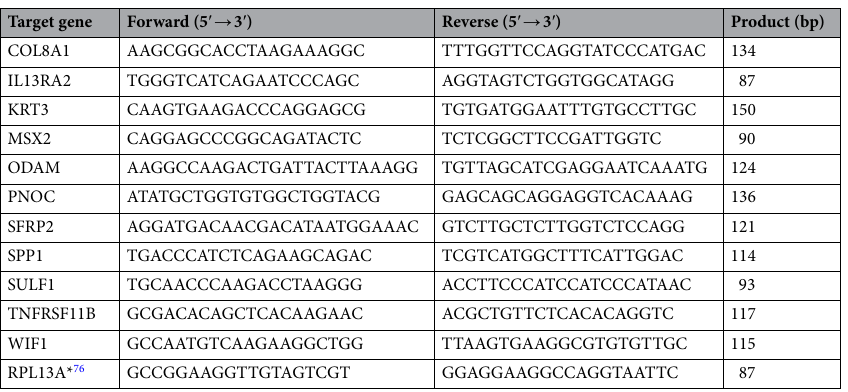
Table 2. Primer pairs used for qPCR. Genes, primer pairs, and product size (bp = base pairs) used for qPCR analysis. *Endogenous control